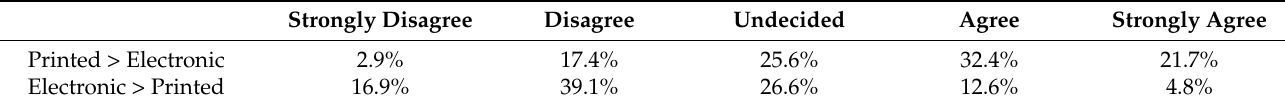
Table 8. Comparison of opinions on paper and electronic materials.